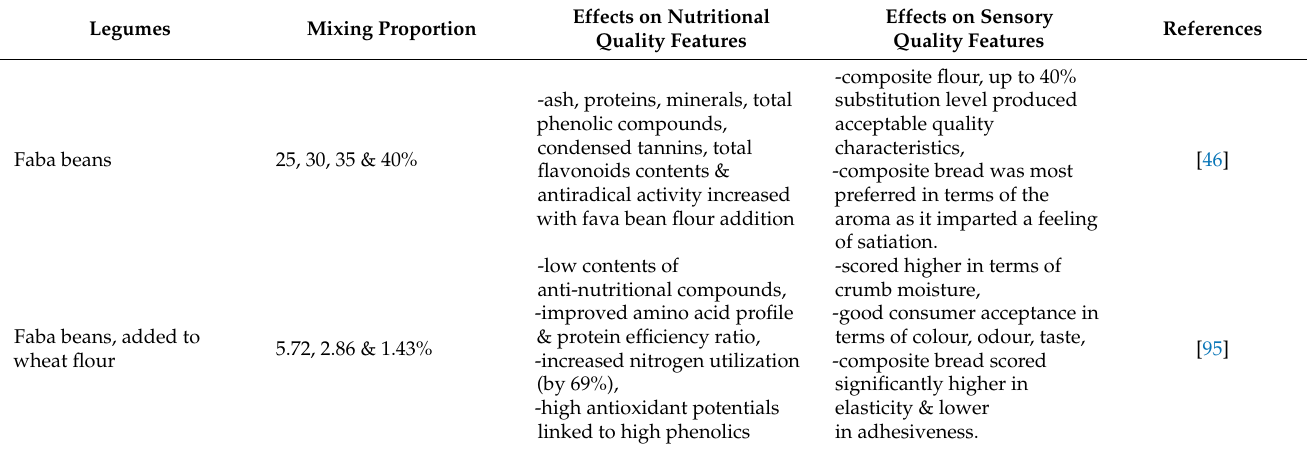
Table 5. Impacts of protein substitution on bread quality